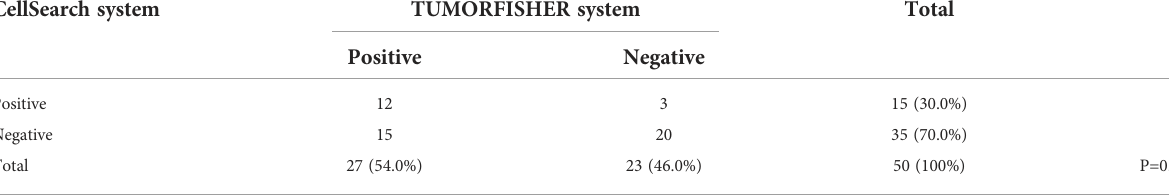
TABLE 2 Checkout rate of CTCs by TUMORFISHER and CellSearch in 50